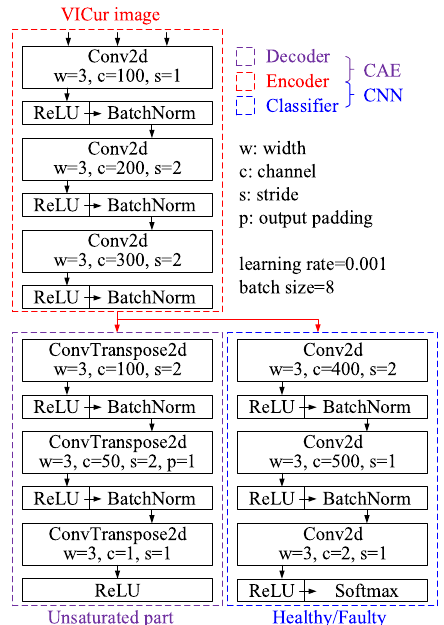
Fig. 7 Structure of a relatively optimal DCNN